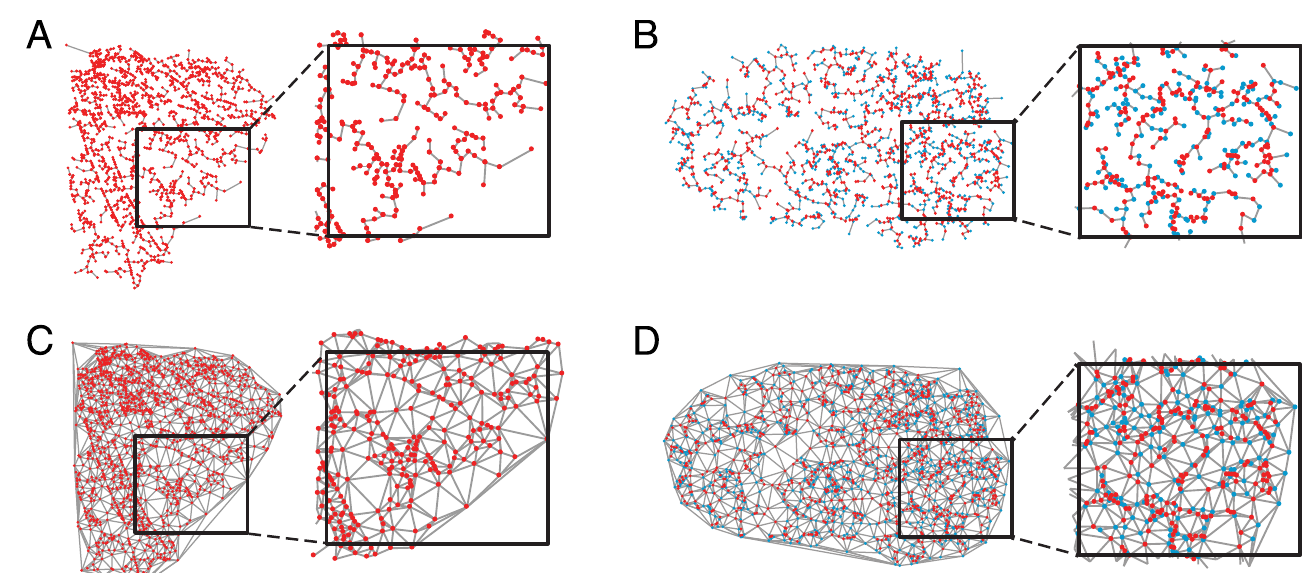
Fig 2. Construction of spatial null model networks. (A,B) The minimum spanning tree MST and (C,D) the greedy triangulation GT for the mycelial network and vasculature network shown in Fig